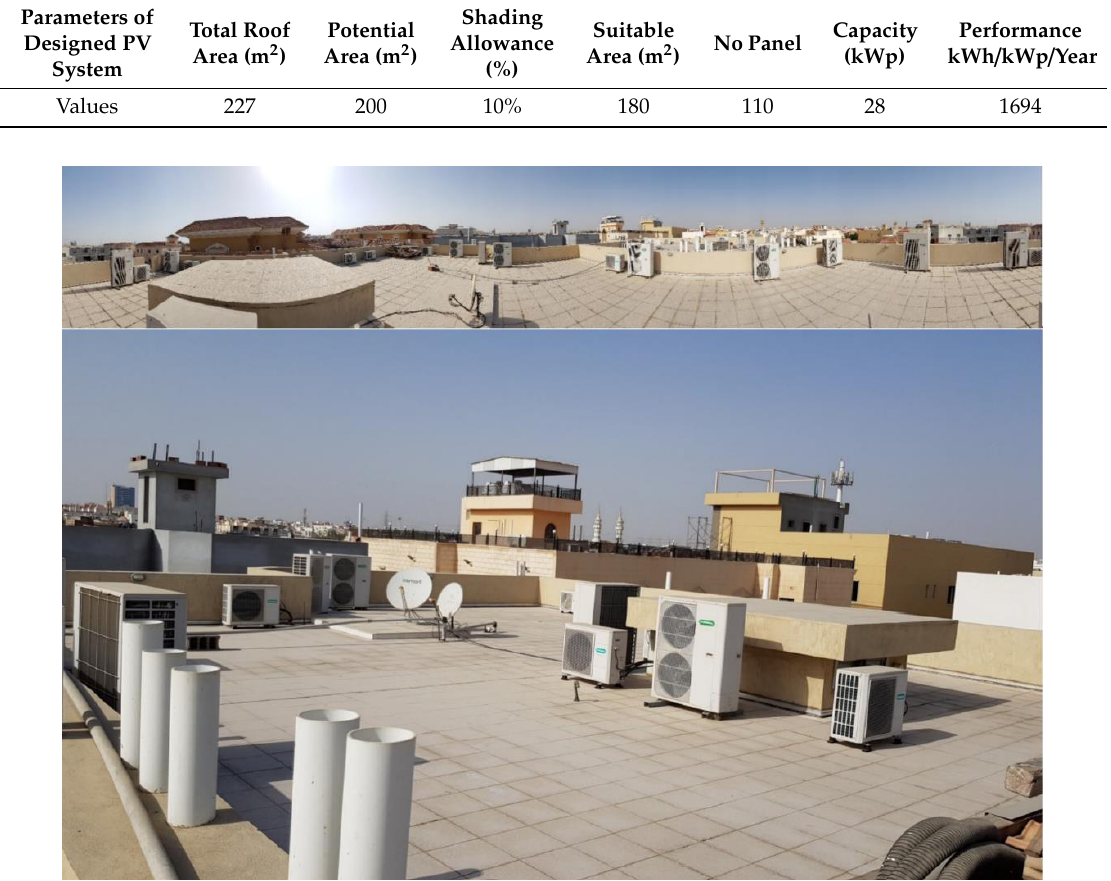
Figure 22. A view of the roof and the installed equipment at Villa 1.